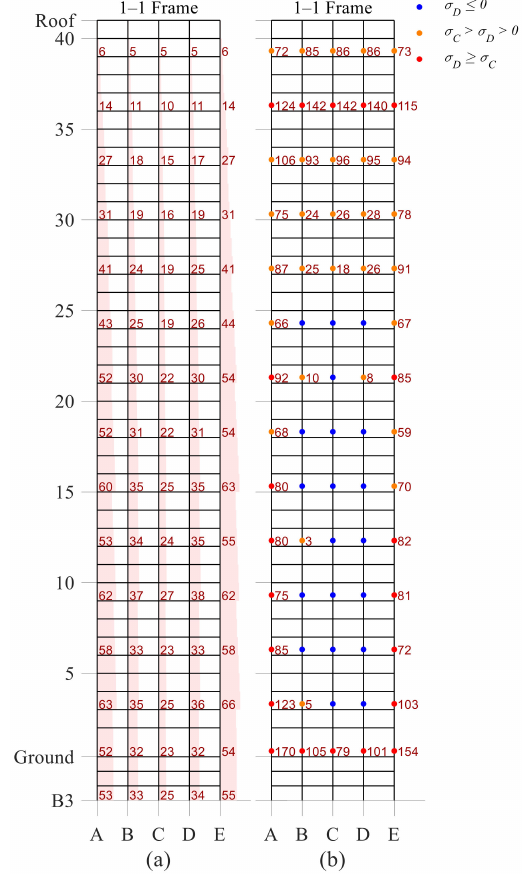
Figure 7. ( a ) Median column normalized peak compressive forces and median peak (%), ( b ) tensile stresses at column splices as built (MPa)